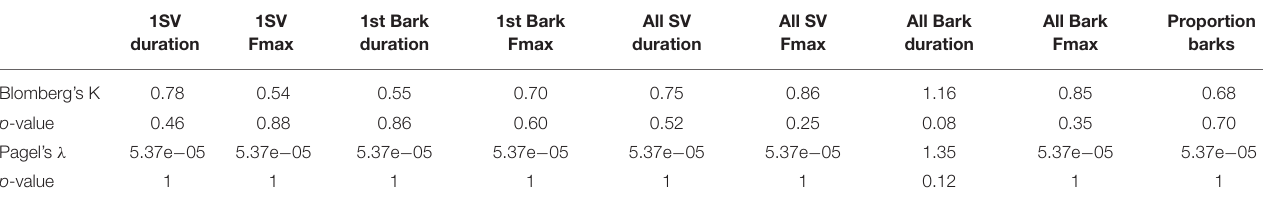
TABLE 2 | Tests for phylogenetic signals in USV characters using both Blomberg’s K and Pagel’s λ .